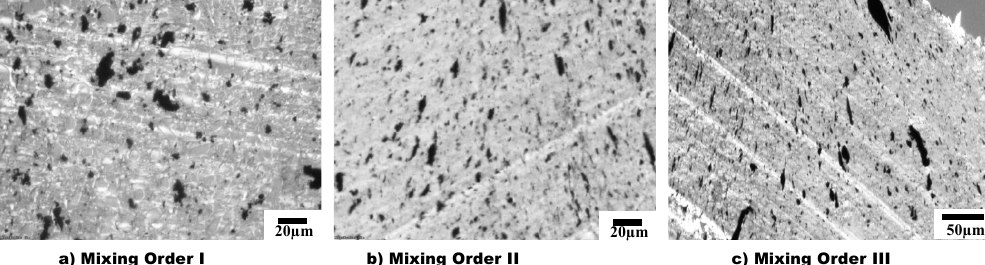
Figure 4. OM images of 1.5 vol% CNT in PS/aPA (25:75) blend nanocomposites for three different mixing orders ( a ) MO I, CNTs are selectively localized in the matrix; ( b ) MO II and ( c ) MO III, show stretched CNTs localized both at the matrix and at the interphase.